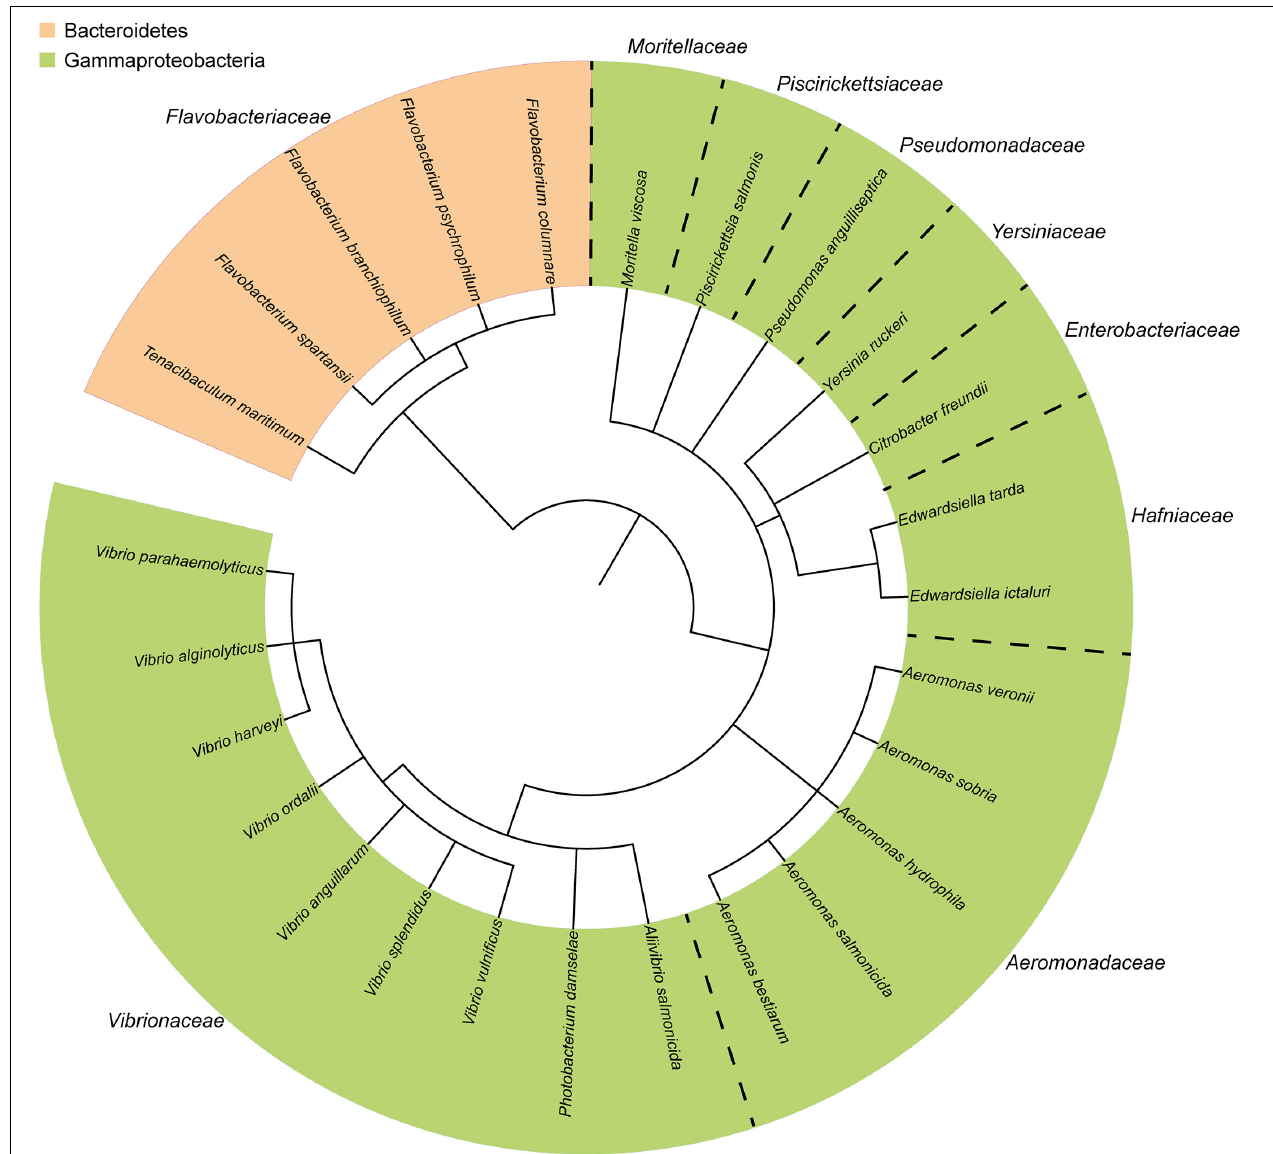
FIGURE 1 | Taxonomic distribution of the most common Gram-negative bacterial fish pathogens. The phylogenetic tree was generated using the phyloT online tool (http://phylot.biobyte.de/), based on annotations from ITOL (http://itol.embl.de/) (Letunic and Bork,